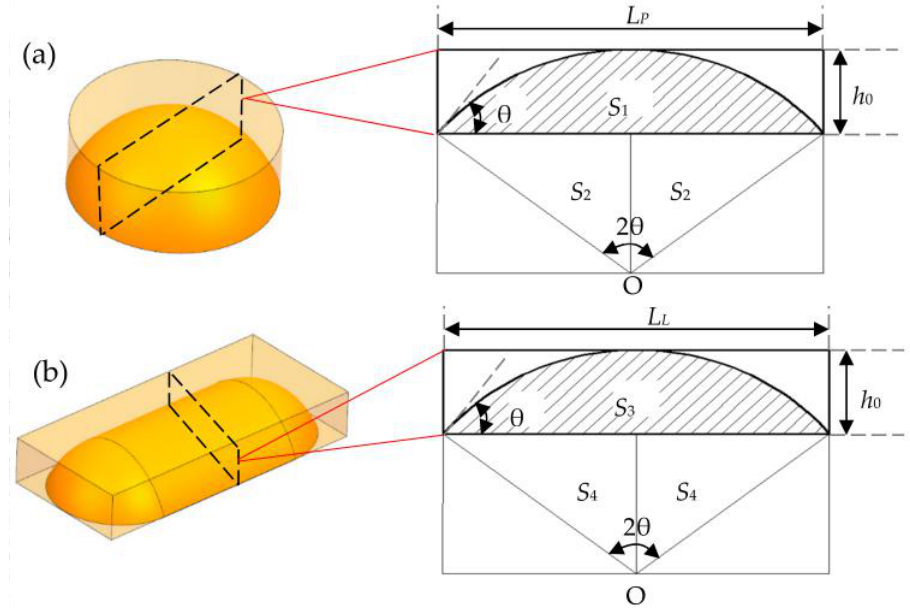
Figure 9. Three-dimensional model of deposition and cross-sectional model of deposition ( a ) point deposition model and ( b ) line trajectory deposition